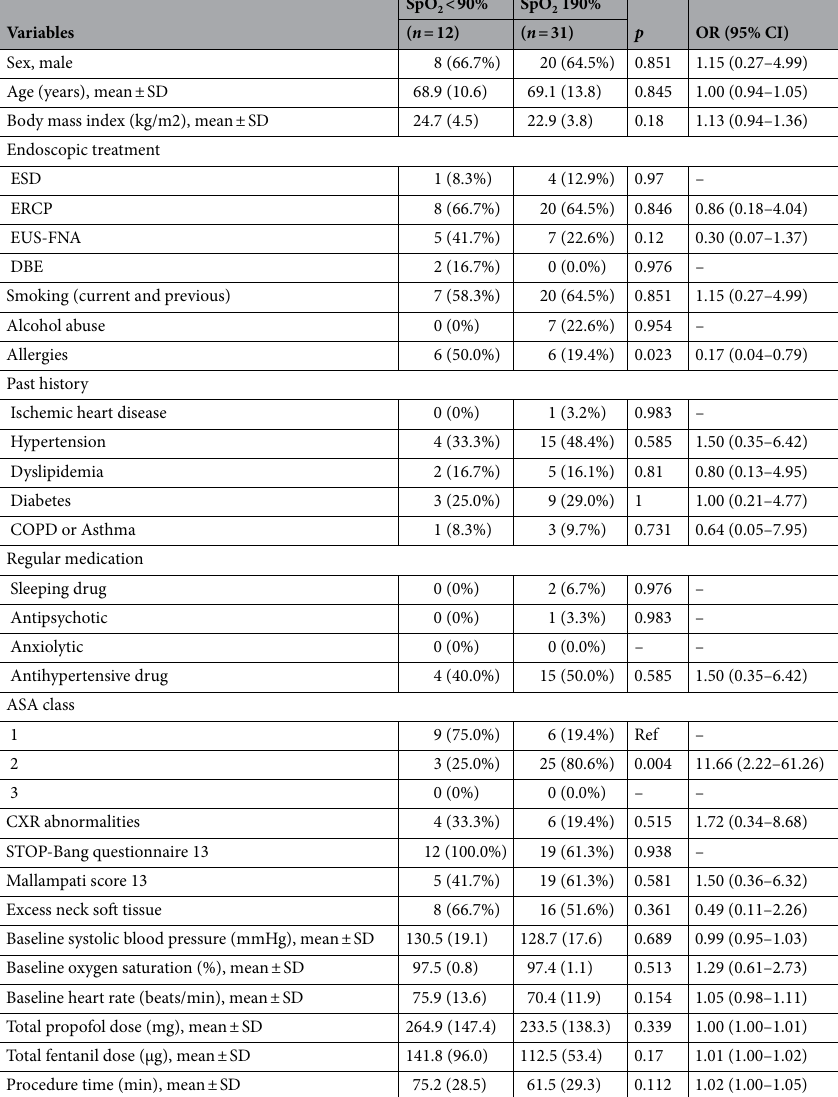
Table 3. Univariate analysis of risk factors associated with oxygen desaturation of SpO 2 < 90%. Qualitative data are presented as n (%). The STOP-Bang questionnaire consists of eight dichotomous (Yes/No) questions: (1) snoring, (2) daytime tiredness, (3) observed apnea, (4) high blood pressure, (5) body mass index ≥ 30, (6) age ≥ 50 years, (7) neck circumference ≥ 40 cm, and (8) male sex. The total score ranges from 0 to 8. ASA American Society of Anesthesiologists, CI confidence interval, COPD chronic obstructive pulmonary disease, CXR chest X-ray, DBE double-balloon enteroscopy, ERCP endoscopic retrograde cholangiopancreatography,